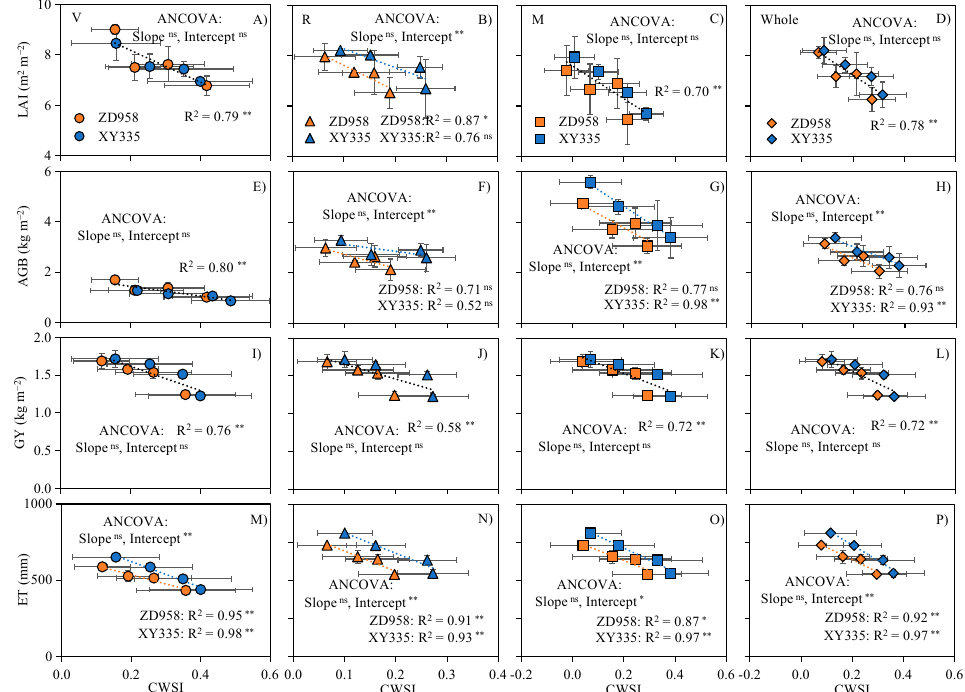
Figure 7. The relationships between leaf area index (LAI), ( A – D ), aboveground biomass (AGB), ( E – H ), grain yield (GY), ( I – L ), and evapotranspiration (ET), ( M – P ) with average crop water stress index (CWSI) during different growth stages of two maize genotypes (ZD958 and XY335). Regression lines are fit for each genotype when either the slopes or intercepts are significantly different, and across all genotypes when both the slopes and intercepts are not significantly different by the ANCOVA test. Values are means ± SD. ns, no significant difference; *, p < 0.1; **, p < 0.05.